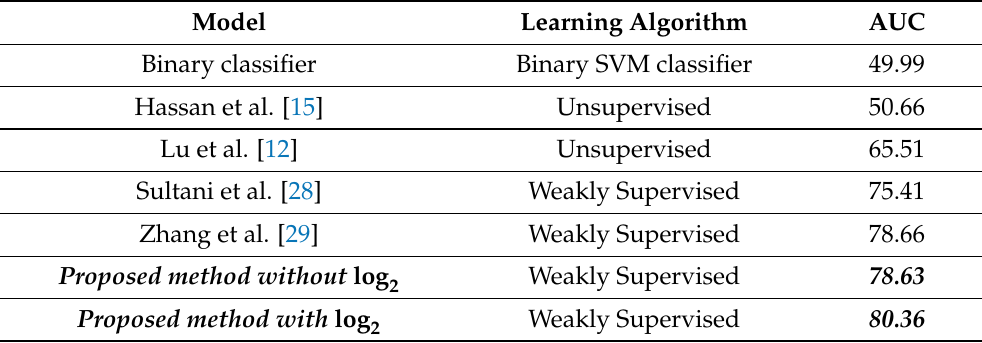
Table 3. Performance comparison using UCF-Crime dataset. The performance of the proposed in this paper appears in